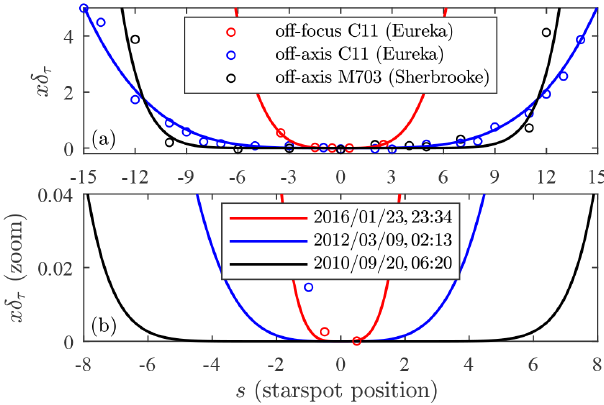
Figure 17. Optical depth increase induced by throughput degrada- tion due to misalignment: star focusing error (red for C11) and cen- tring error (blue for C11 and black for M703). For focusing, the positions ( s ) represent focusing stage steps (at ∼ 10arcsec per step increase in the confusion circle); for centring, they represent high- resolution camera-binned pixels, at 3arcsec per bin for M703 and 2arcsec per bin for C11. Panel (a) shows the data and a | s | b fit; panel (b) shows the same fit as panel (a) but zoomed-in to low OD. (The measurement date and UTC time are indicated in the legend of panel b